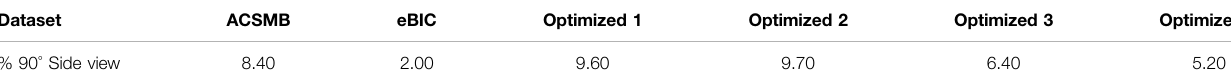
TABLE 1 | Quantifying the preferential orientation bias. As a proxy for determining the degree of preferred orientation bias in the datasets, the number of particles that belonged to classes representing a complete side view of CDC48A was divided by the number of particles in all good classes, for each dataset. Values of 9.0 ± 1.0% correspond to an even orientational distribution.